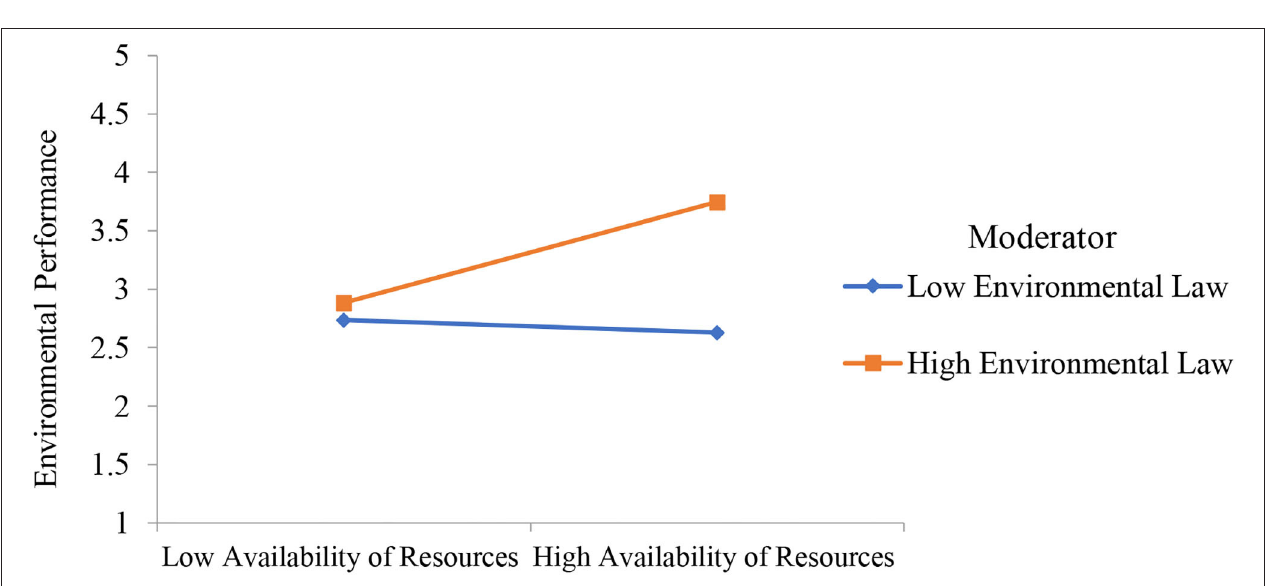
FIGURE 5 | Moderation effect of environmental law strengthens the relationship between performance and environmental performance.